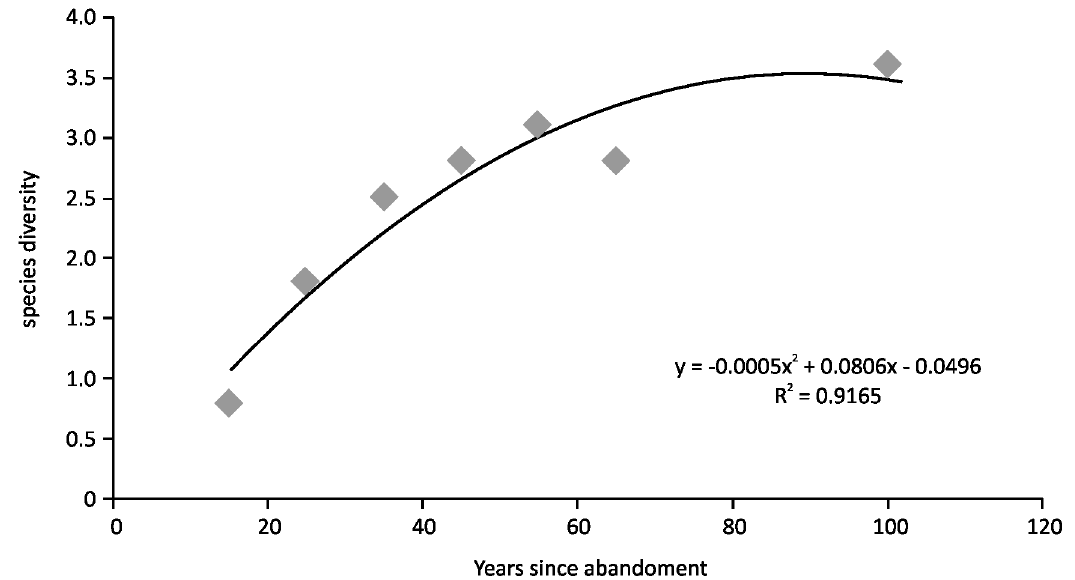
Figure 2. Shannon-Wiener species diversity change with time of field abandonment (forests set at 100 years) (n = 55).